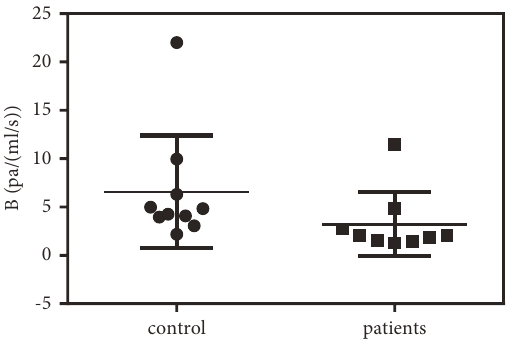
Figure 5: Flow resistance analysis of SMV.